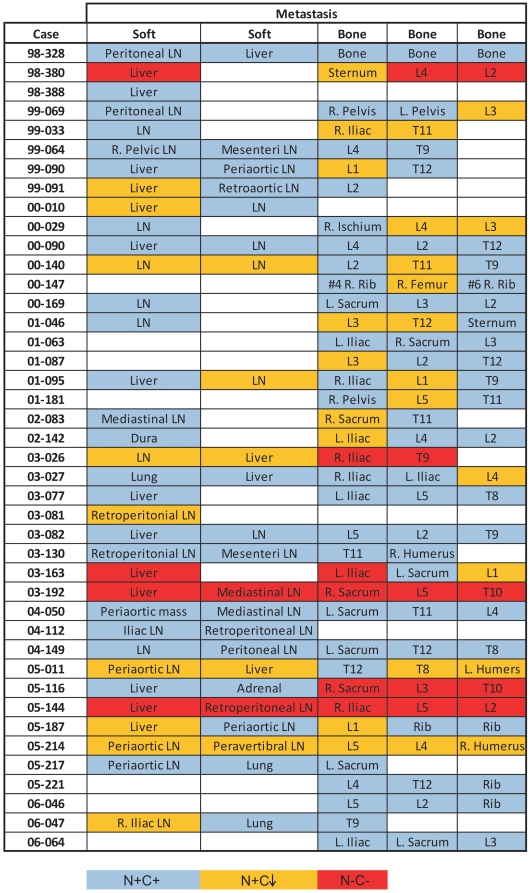
The heterogeneity of AR expression in individual patients.Multiple metastatic sites of 42 CRPC patients had been analyzed by IHC using 2 AR antibodies. The staining results were summarized as N+C+ (blue), N+C↓ (orange) and N-C- (red). LN = lymph node; L =  lumbar vertebra; R. =  right; L. =  left; T =  thoracic vertebra.